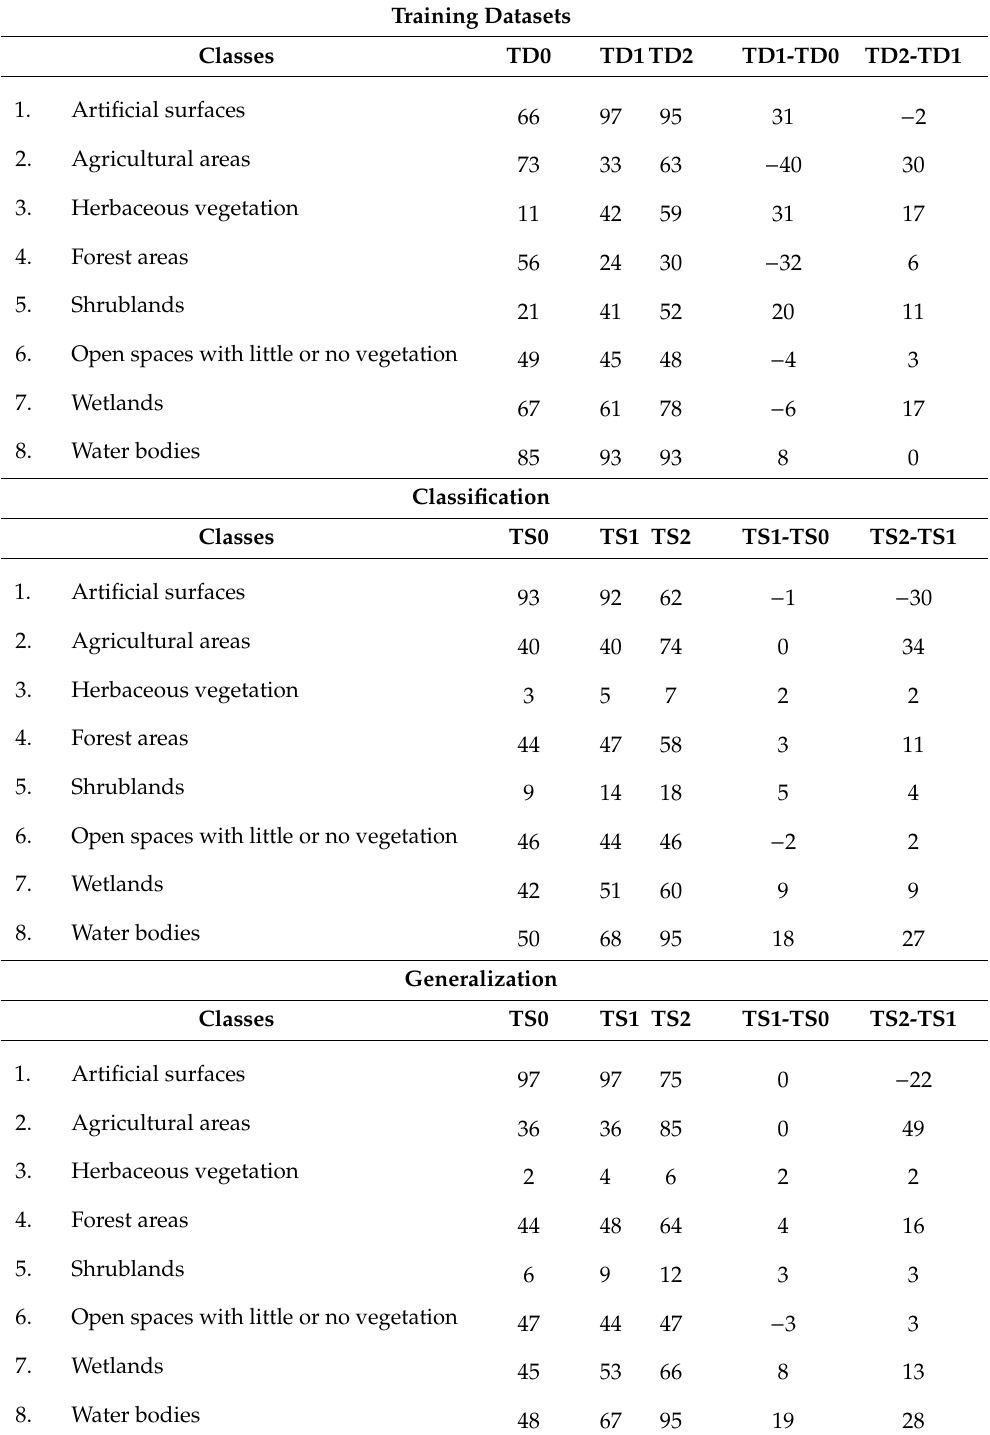
Table 10. Producer’s Accuracy per class (%) (equal to 100 minus the omission errors) for study area A, of the training datasets TD0, TD1 and TD2 and of the maps resulting from the classification with TS0, TS1 and TS2 (Figure 11). The reference data used are the maps derived from the COS 2018 with the nomenclature